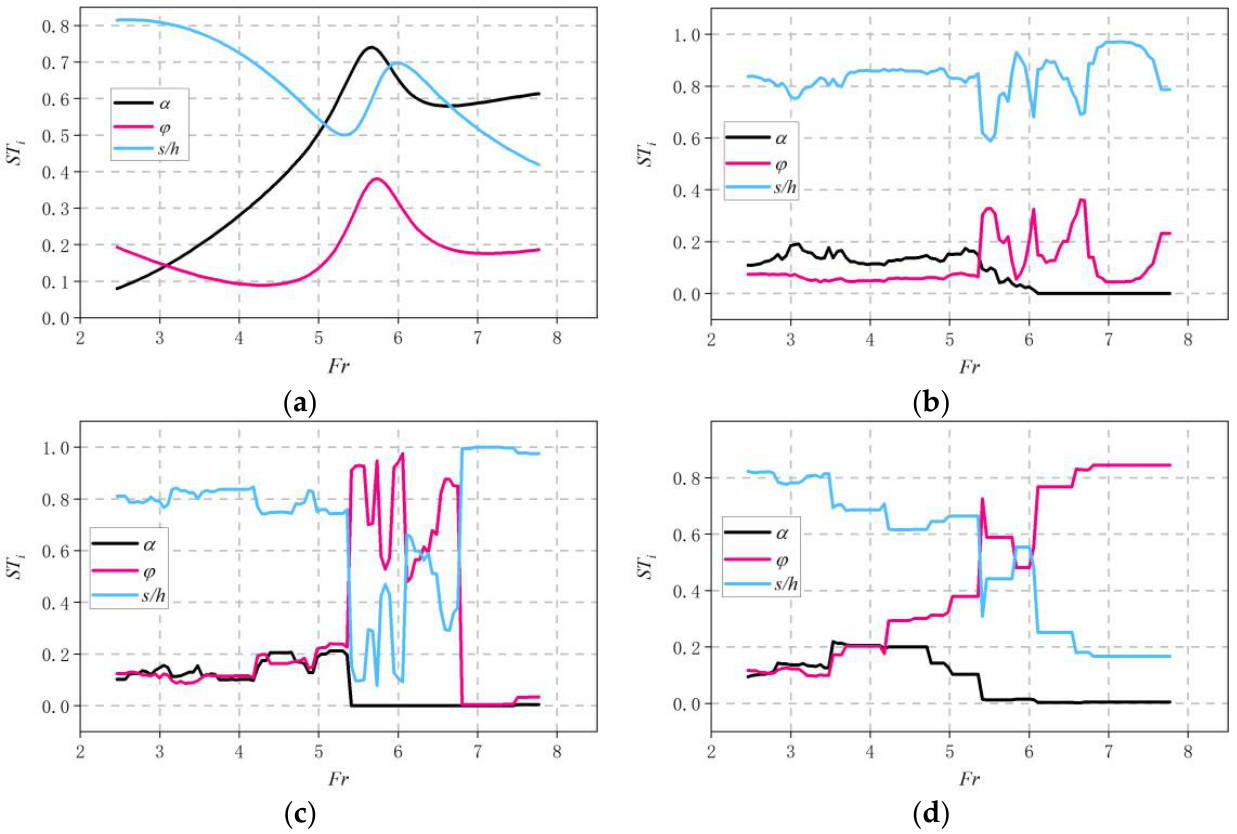
Figure 6. Evolution of the total Sobol’s indices. ( a ) SVR. ( b ) RF. ( c ) GBR. ( d ) XGB.